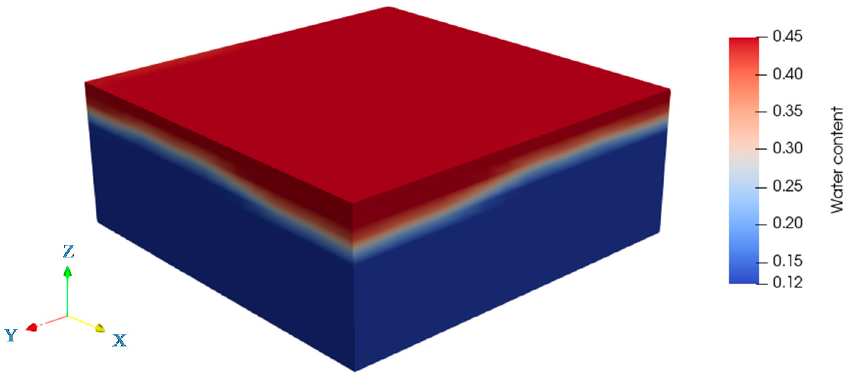
Figure 5. Distribution of water content at t = 0.5 h.